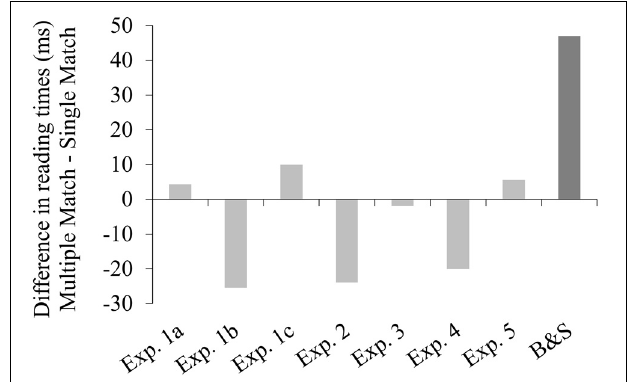
FIGURE 3 | Difference in reading times between the multiple match (main clause match/embedded match) and single match (main clause match/embedded mismatch) conditions in the pronoun + 1 region across Experiments 1–5, compared to Badecker and Straub’s (2002) Experiment